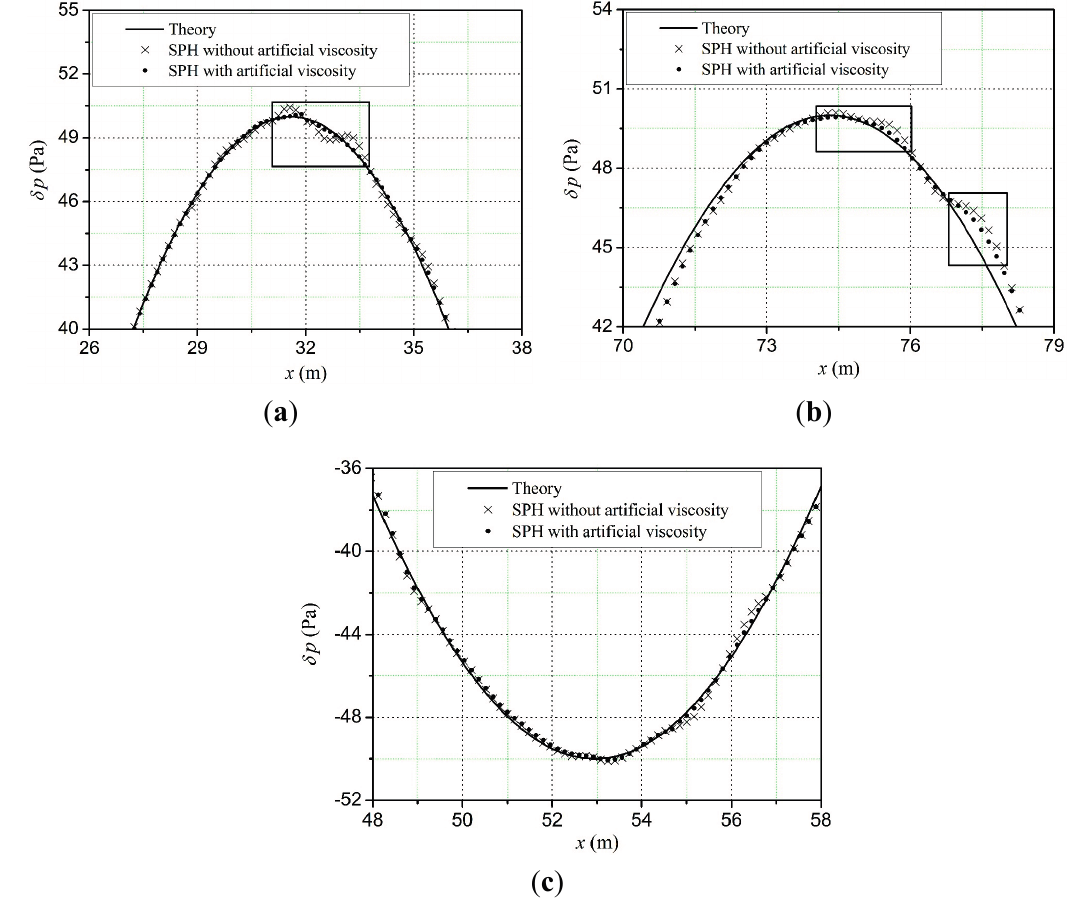
Figure 2. Comparison of SPH results (with and without artificial viscosity) with theoretical solutions. ( a ) Detailed view of the first peak; ( b ) detailed view of the second peak; ( c ) detailed view of the